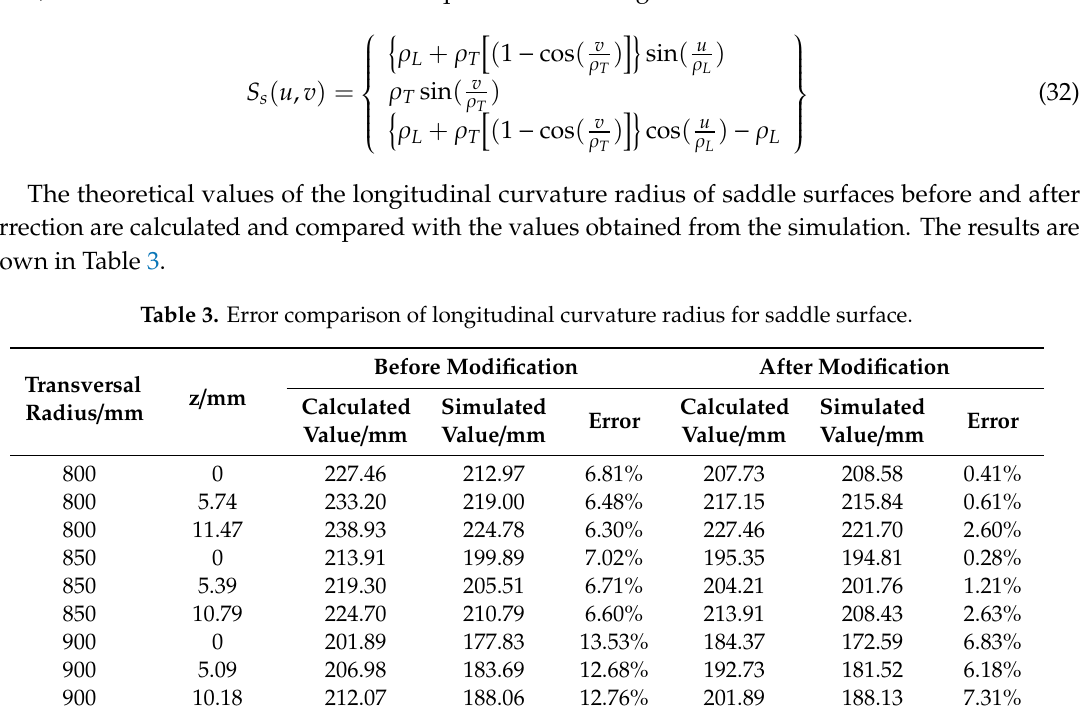
Figure 9. Relationship between longitudinal strain and z-coordinate obtained from numerical simulation: ( a ) convex surface; ( b ) saddle surface.